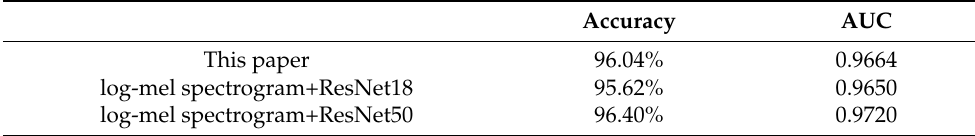
Table 8. Single-blade sound segmentation experimental